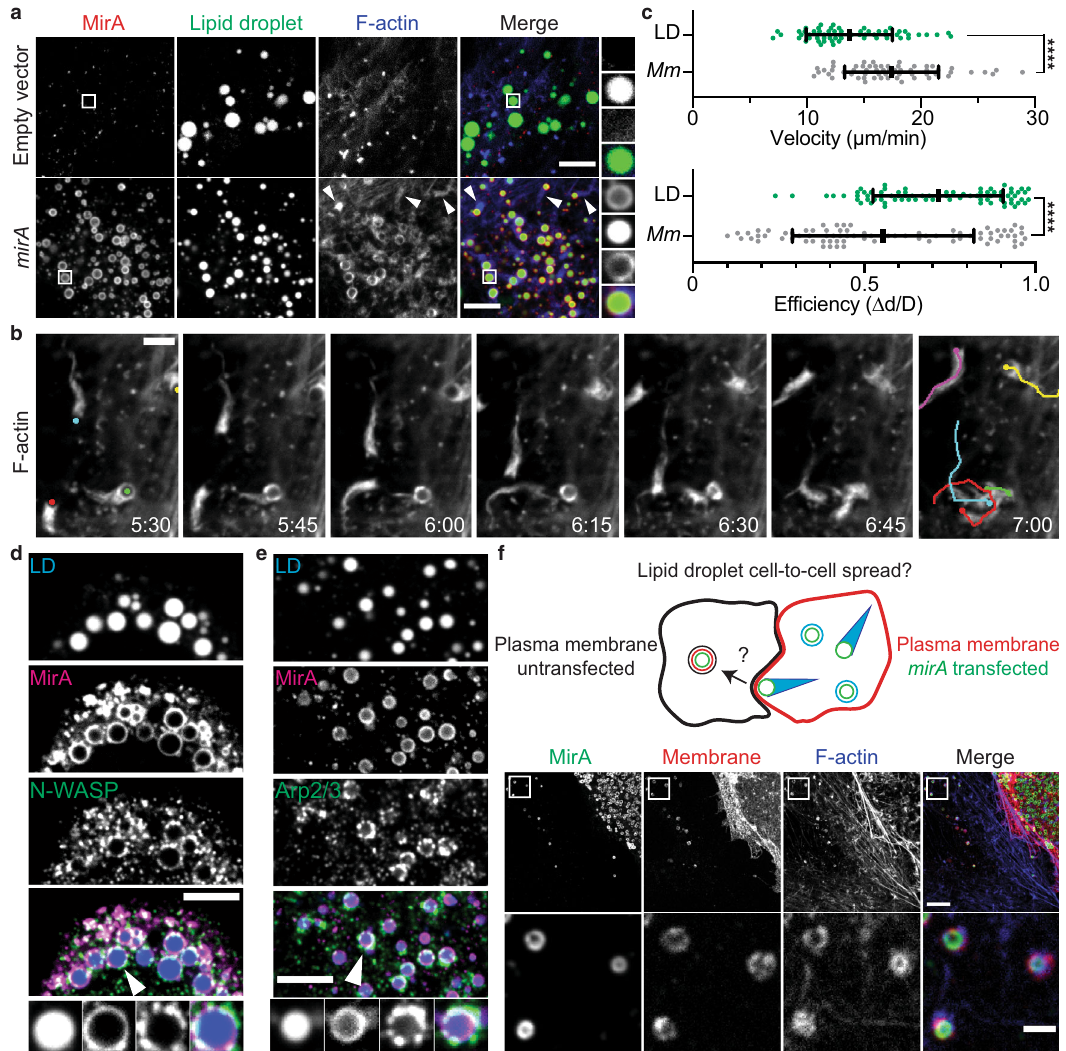
Fig. 4 MirA localizes to eukaryotic lipid droplets and mimics M. marinum actin-based motility. a Ectopically expressed MirA (red; anti-MirA) in U2OS cells localizes to lipid droplet organelles (green; BODIPY 493/503) and induces actin polymerization (blue; Phalloidin-iFluor 405). Arrows indicate actin comet tails. Scale bar is 3 µ m. b Live-imaging snapshots of mirA Δ PE transfected U2OS cells expressing the F-actin marker F-tractin-mCherry. Scale bar is 3 µ m. Accompanies Supplementary Movie 2. c Velocity of movement and ef fi ciency of movement measurements of M. marinum ( Mm ; gray) versus lipid droplets (LD; green). The data are a combination of ≥ 20 measurements over three independent biological experiments and the bar indicates the mean ± SD. Statistical analysis used a two-tailed Mann – Whitney U test; **** p < 0.0001. Transfected MirA (red; anti-MirA) localizes with d N-WASP (green; anti-N-WASP) or e Arp2/3 (green; anti-P34) at the surface of lipid droplet organelles (blue; BODIPY 493/503). Scale bar is 3 µ m and the white arrow in merge panel indicates highlighted example. f MirA- (green; anti-MirA) coated lipid droplets spread from donor mirA -transfected A549 cells expressing a plasma membrane marker (red; RFP-CAAX) to unmarked and untransfected recipient A549 cells. Bottom panel corresponds to boxed region. Scale bar is 5 µ m (upper panel) and 2 µ m (lower panel). Data shown in a , b , d – f are representative of at least three independent experiments. Source data are provided as a Source data fi